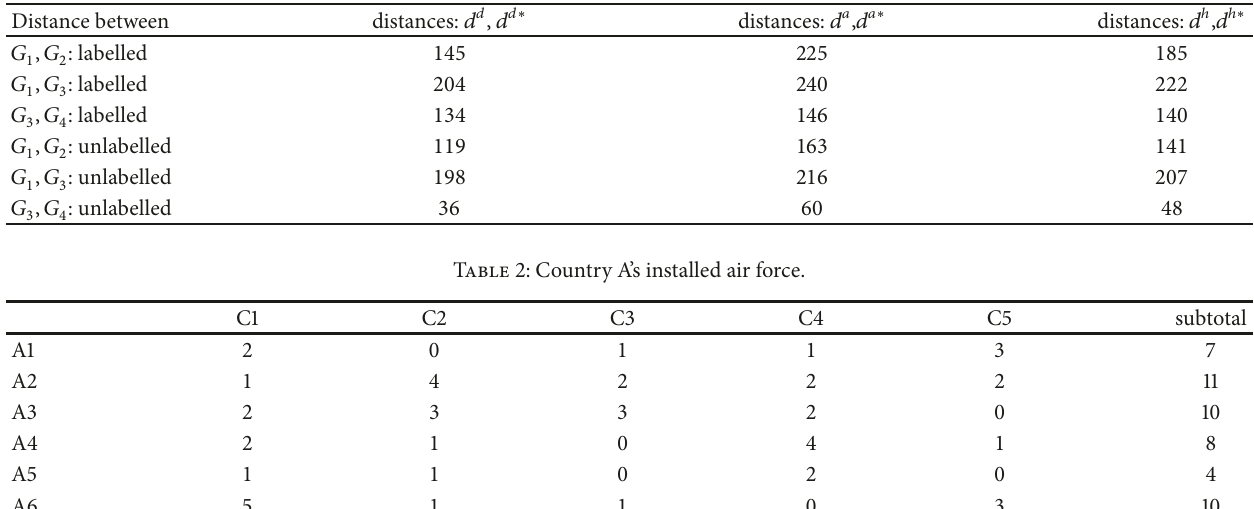
Table 1: Implementations of all the metrics.